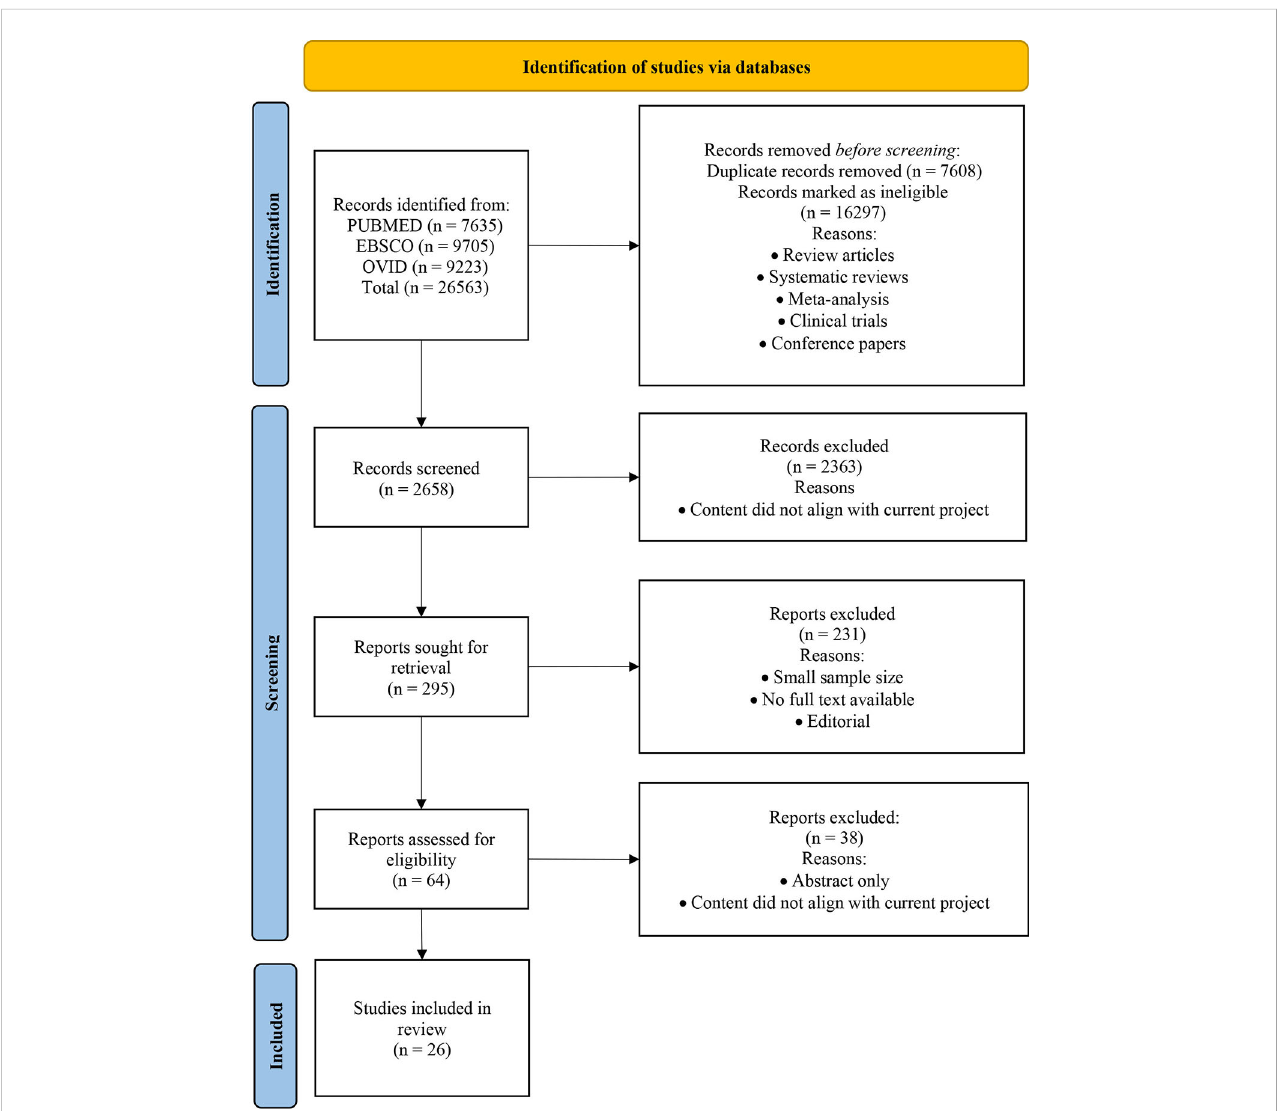
FIGURE 1 PRISMA Flow chart of selection of studies for the systematic